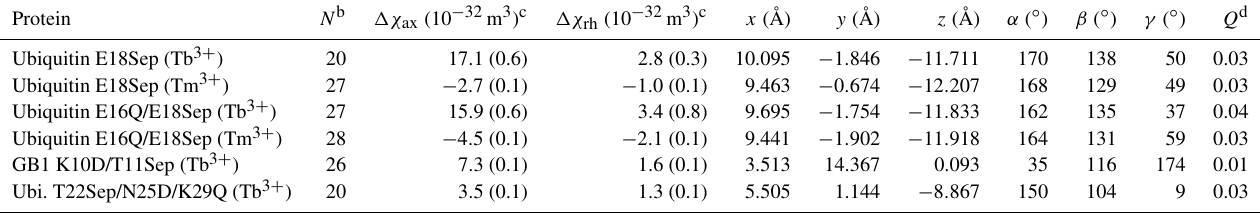
a The (cid:49)χ -tensor fits used PCSs measured with Tb 3 + and Tm 3 + , using Y 3 + as the diamagnetic reference. The metal coordinates and tensor parameters for the ubiquitin and GB1 mutants are reported relative to the NMR ensemble structure of ubiquitin (PDB ID: 2KOX; Fenwick et al., 2011) and the crystal structure of GB1 (PDB ID: 1PGA; Gallagher et